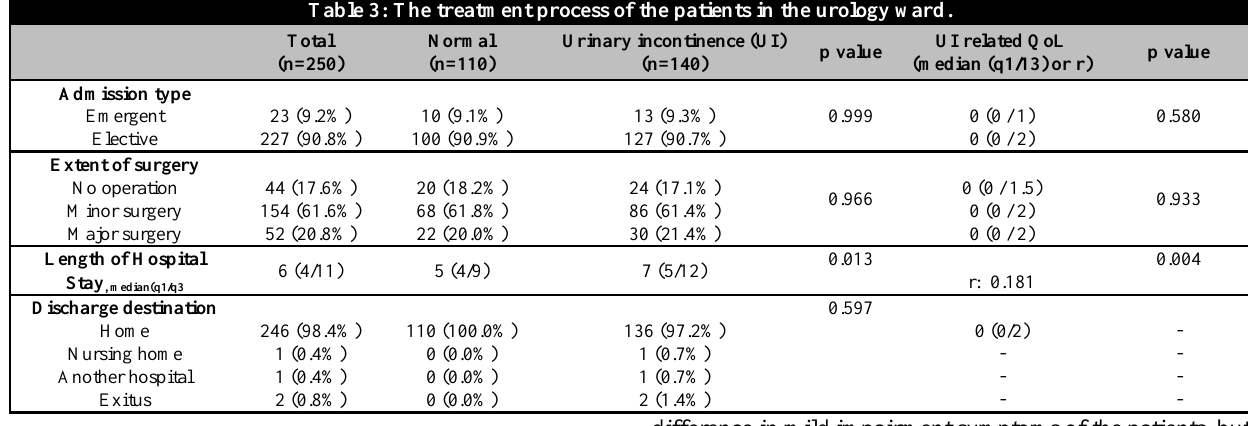
Table 3: The treatment process of the patients in the urology ward.